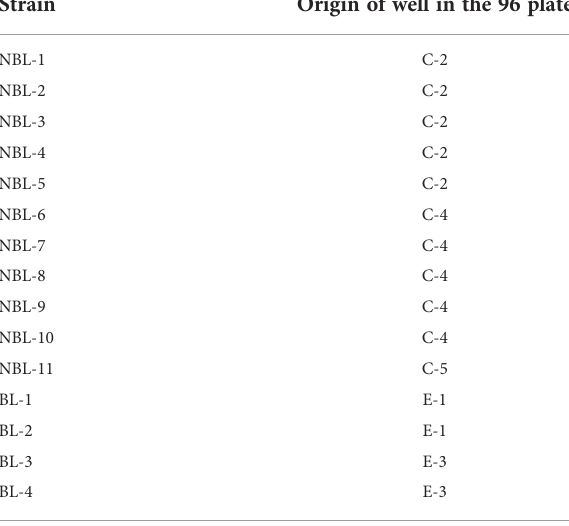
TABLE 1 Correspondence table of each strain and its origin.